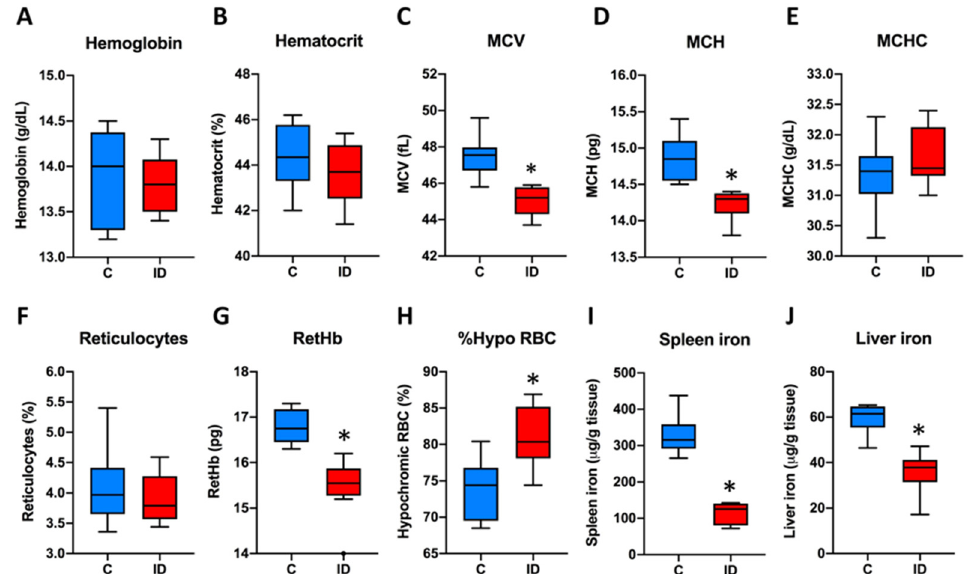
Figure 1. Hematological parameters and iron stores measured on Day 21. ( A ) Hemoglobin concentration; ( B ) hematocrit; ( C ) mean corpuscular volume; ( D ) mean corpuscular hemoglobin; ( E ) mean corpuscular hemoglobin concentration; ( F ) reticulocyte count; ( G ) reticulocyte hemoglobin content; ( H ) percentage of hypochromic red blood cells; ( I ) iron content in the spleen; ( J ) iron content in the liver. C (blue boxes), control group; ID (red boxes), ID group; N = 8 in each group. Box-plots represent medians, interquartile ranges and upper and lower values according to Tukey’s method. * p < 0.05, significantly different from control group.